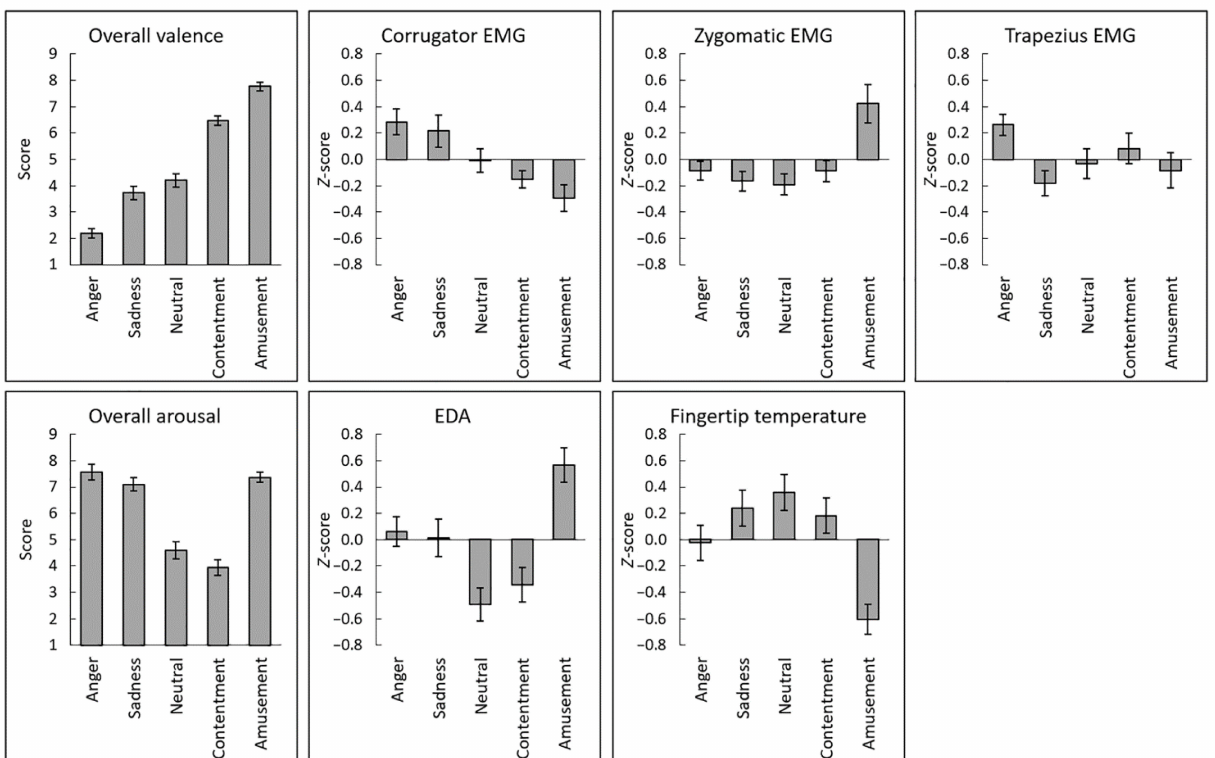
Figure 1. Mean ( ± standard error) overall ratings of valence and arousal, electromyography (EMG) recorded from the corrugator supercilii, zygomatic major, and trapezius muscles, electrodermal activity (EDA), and fingertip temperature across films. Physiological data were standardized within